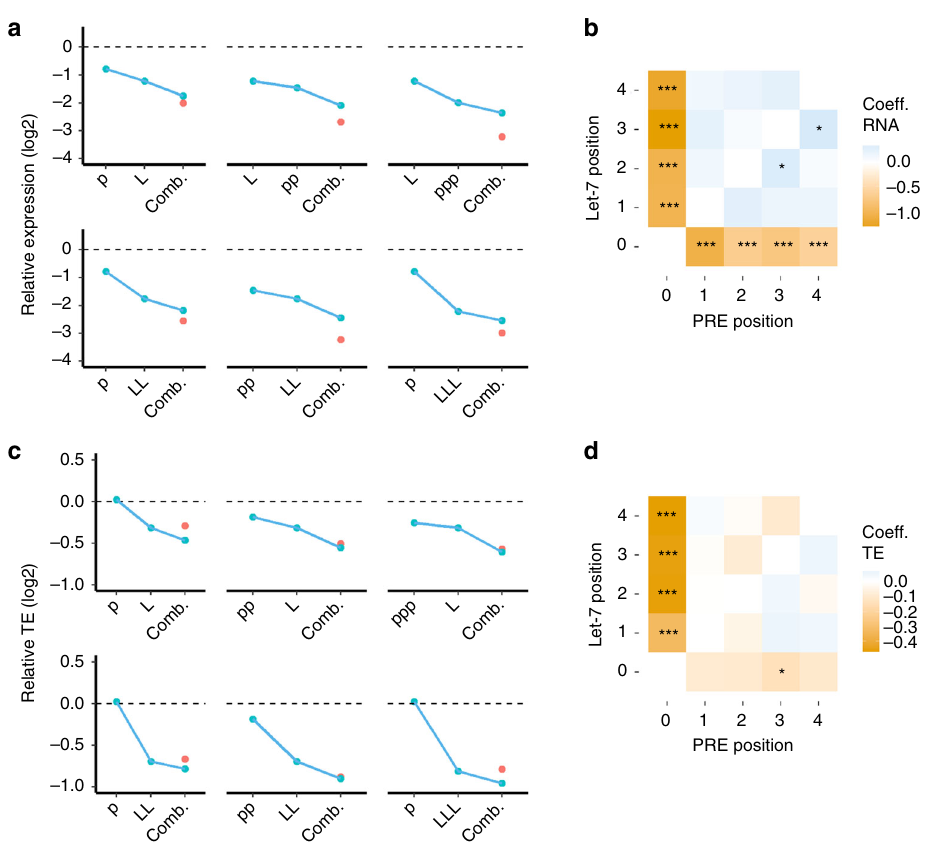
Fig. 4 Pumilio and miRNAs function independently. a The effect of a let-7, PRE or a combination of the two elements on relative expression, and c relative TE. The median relative expression or TE is plotted across all barcodes and replicates. Red dot, the product of each individual effect, the expected result assuming independence. The regression coef fi cients from the linear regression model for RNA expression ( b ), and TE ( d ), for the parameters corresponding to let-7 or PREs alone or interactions between positions containing let-7 or PREs. For a and c L = let-7 binding site, p = PRE, * P < 0.05, ** P < 0.01, *** P < 0.001, t